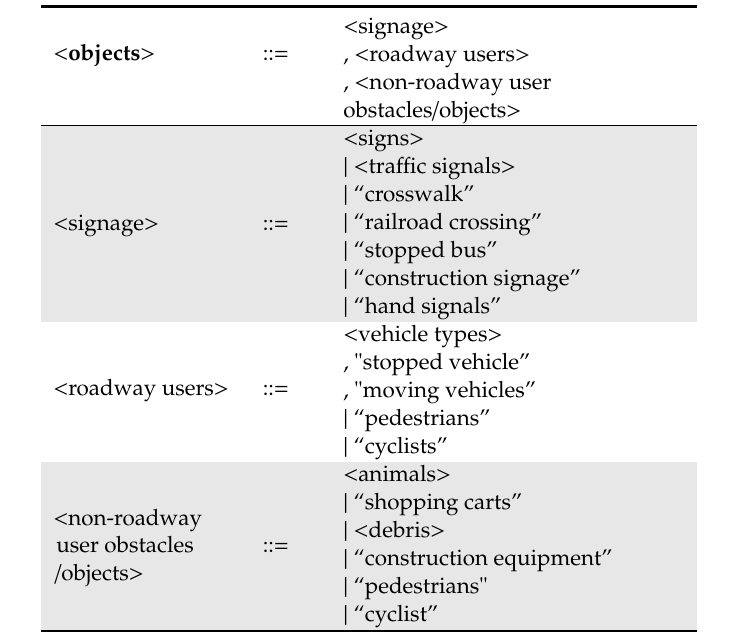
Table A7. The 3rd stage of < environment >< objects > .